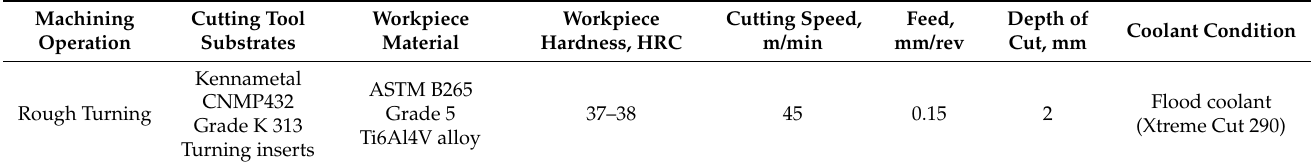
Table 2. Cutting parameters for machining of Ti6Al4V